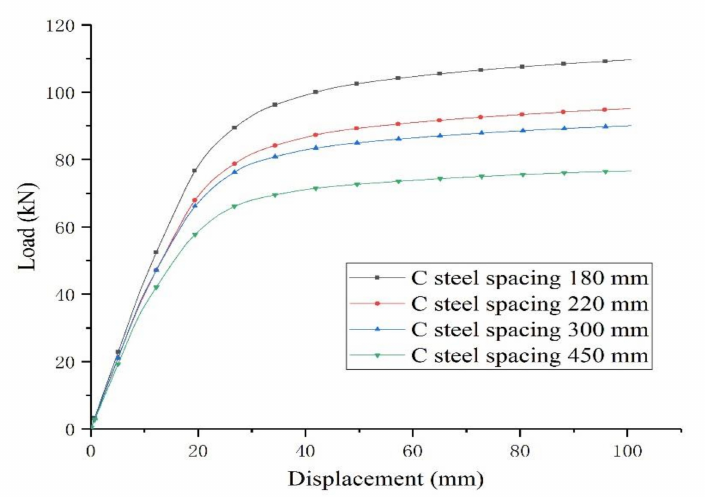
Figure 19. Load displacement curves of composite slabs with different cold-formed thin-walled C steel channels